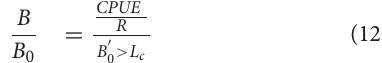
(cid:48) > L where B c indicated the exploitable fraction ( 0 unfished biomass ( B 0